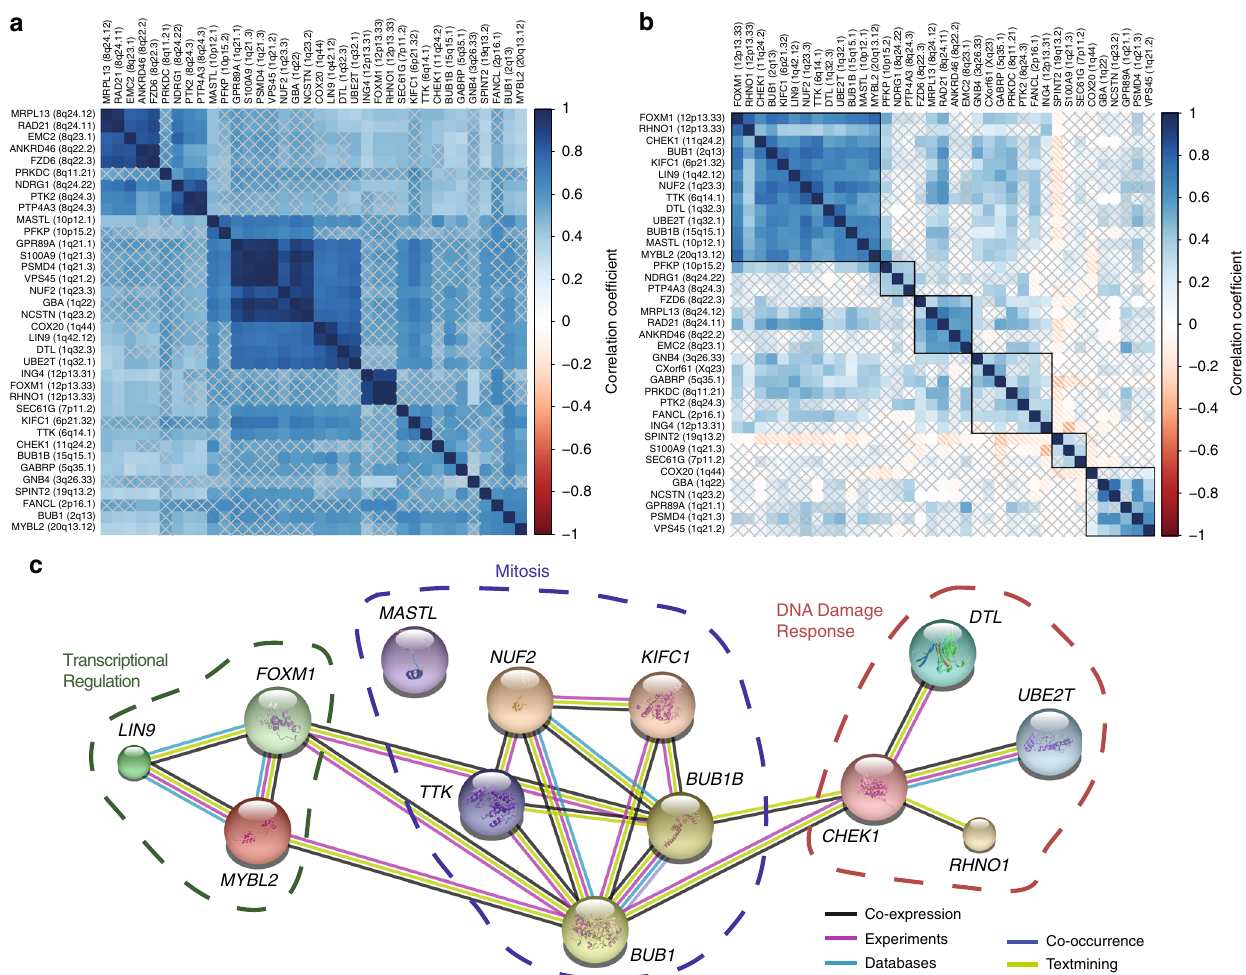
Fig. 2 A subset of tumor addiction genes that are co-upregulated have roles in cell cycle progression, mitosis and DNA damage response. Copy number ( a ) and gene expression ( b ) levels of 37 tumor addiction genes were pairwise correlated and tested for statistical signi fi cance using Pearson method in the TNBC tumors of the Guy ’ s TNBC-enriched cohort ( n = 82). Their correlation coef fi cients were hierarchically clustered using Ward distance method, and displayed as levelplots. In the gene expression correlation heatmap highly correlated genes are surrounded by black rectangles, representative of underlying clusters from hierarchical clustering method whereas a cross denotes insigni fi cant p -value as per level of 0.05. c Interconnectivity among the 13 co-upregulated tumor addiction genes is displayed based on STRING networks. Genes with shared functional roles are